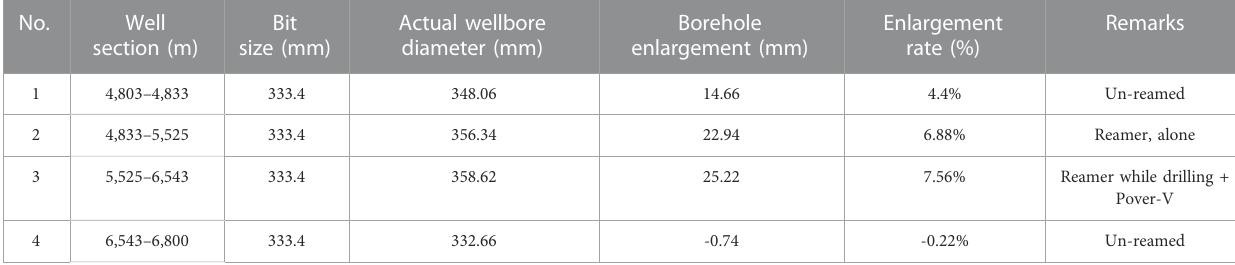
TABLE 1 Detailed data of borehole